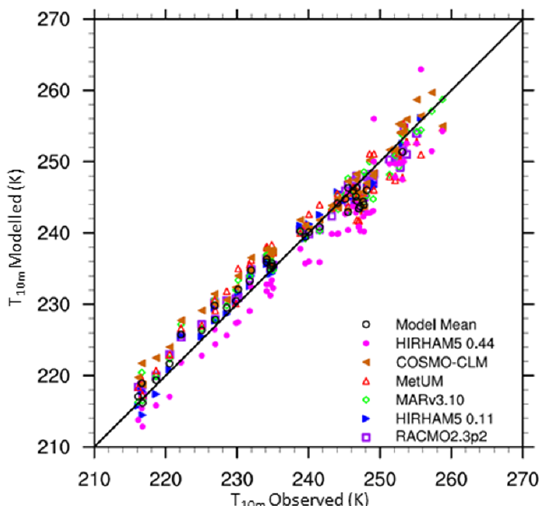
Figure 2. Modelled surface temperature as a function of observed 10m snow temperature (Van Wessem et al., 2014). Observations not fully located on the model ice mask are